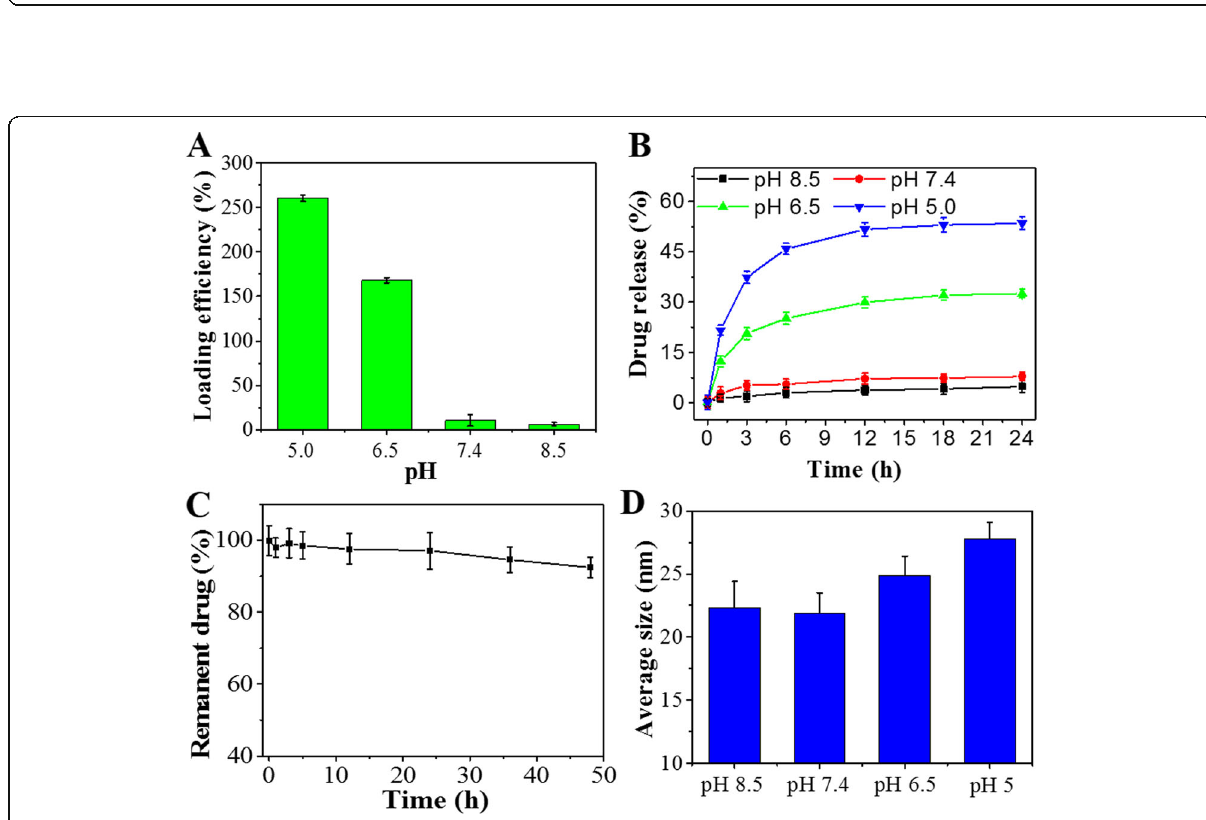
Fig. 3 a Loading efficiency of Ft-RGD in various pH conditions. b RV release profile from RV@Ft-RGD in various pH conditions from 5.0 to 8.5. c The permanent RV in RV@Ft-RGD in physiological condition. d The average size change of RV@Ft-RGD in various pH conditions from 5.0 to